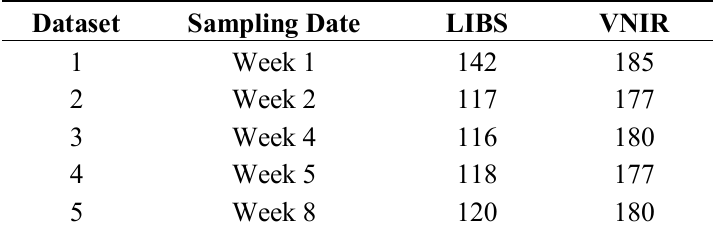
Table 3. Sampling period and spectral data collected using the LIBS and VNIR